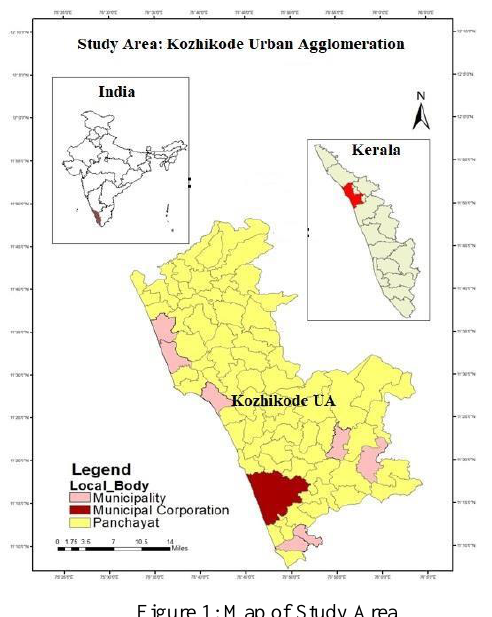
Figure 1: Map of Study